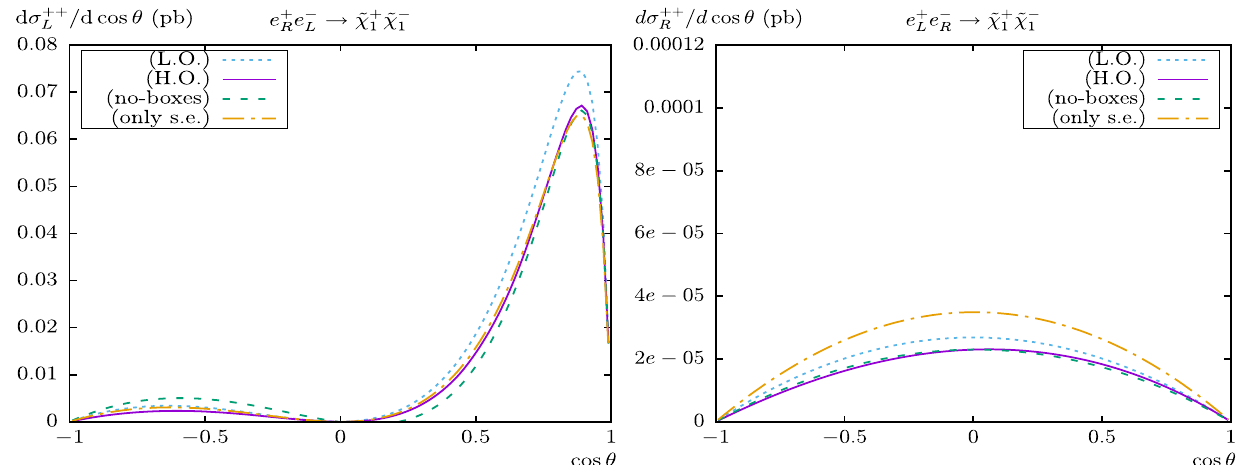
˜ χ − ) . The left handedpositrons)andcharginoswithpositivehelicitywithinthebench- 1 1 mark point C model according to Ref. [39]